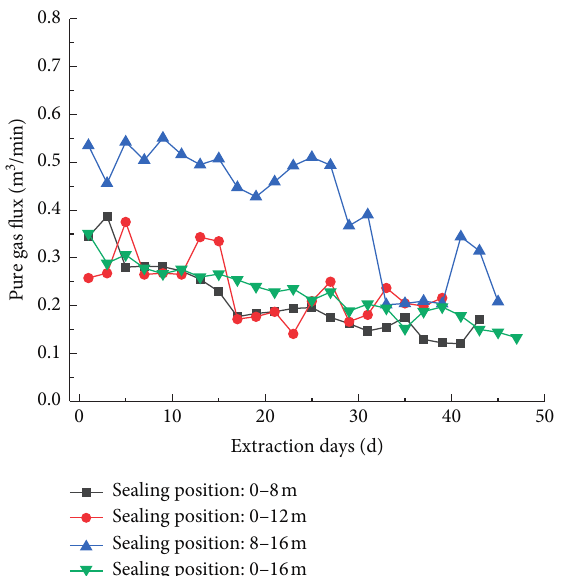
Figure 8: Curve of pure gas flux changing with time in the